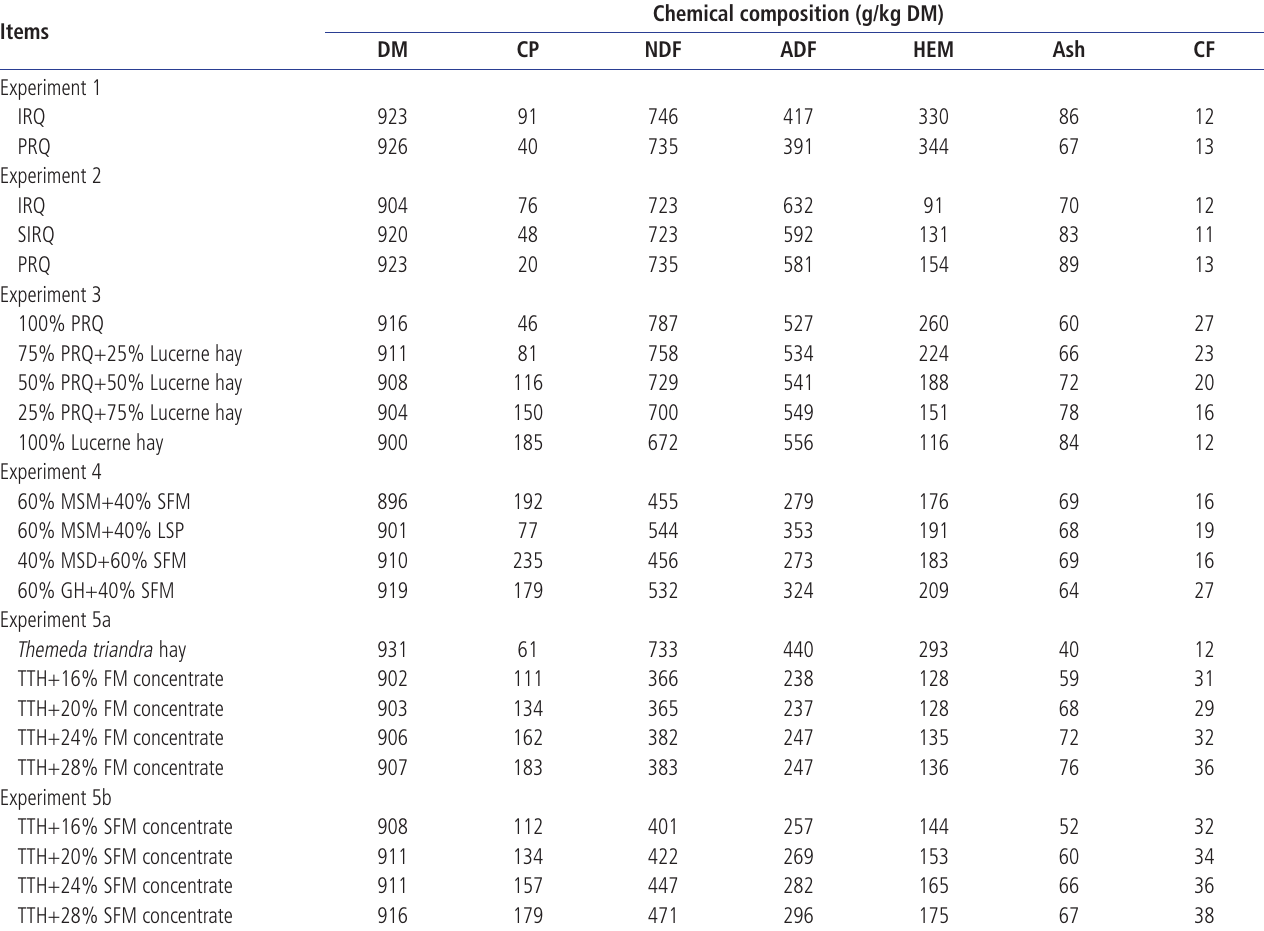
Table 1. Chemical composition and design of treatment diets